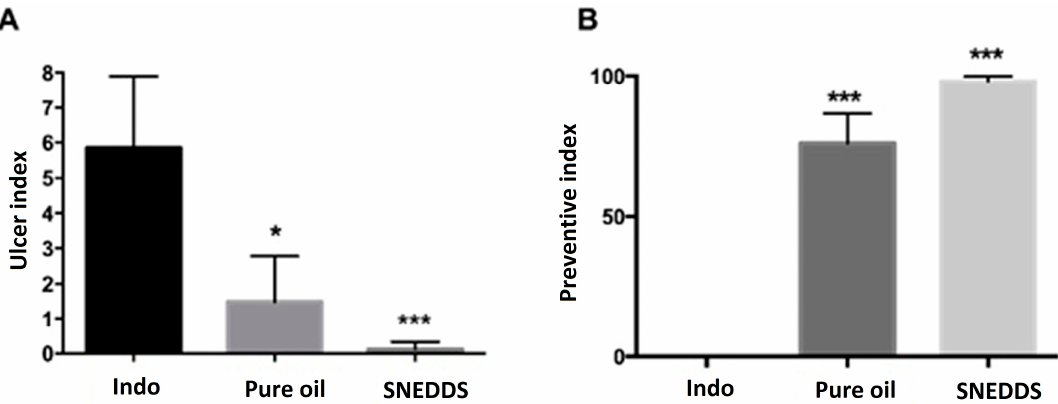
Figure 2. Bar graphs showing the effect of indomethacin, pure omega-3 oil, and SNEDDS formula on ulcer index ( A ) and preventive index ( B ). Data are presented as mean ± S.E.M. * Significantly different from indomethacin at p < 0.01, *** Significantly different from indomethacin at p < 0.001. Indo: Indomethacin, Pure oil: omega-3 oil, SNEDDS: omega-3 formula.